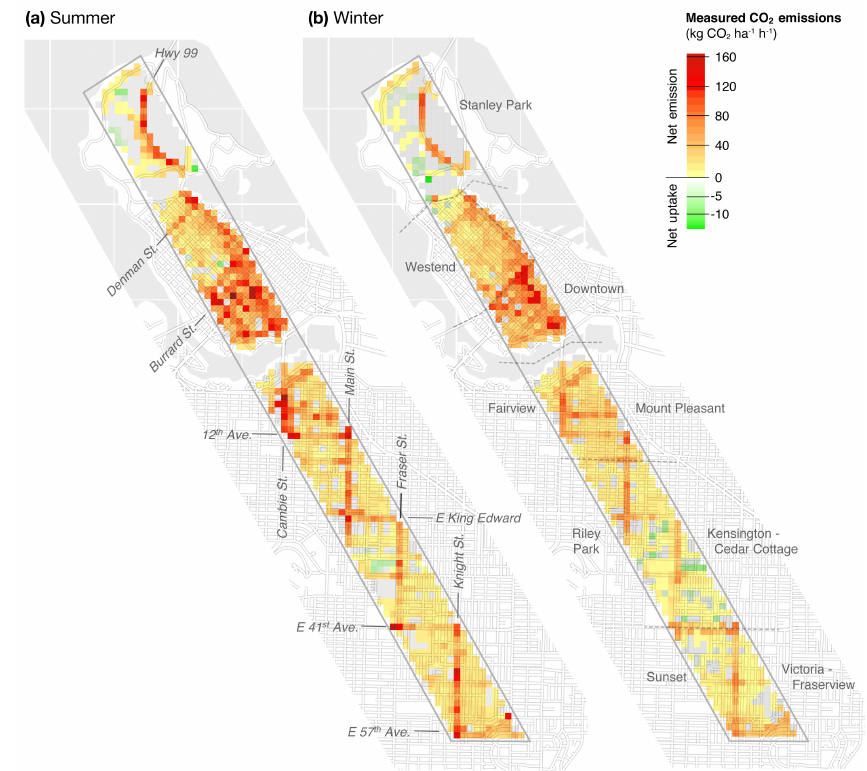
Figure 6. Measured emissions (calculated from mixing ratios using the aerodynamic resistance approach in Eq. 1) for (a) summer and (b) winter campaign at a resolution of 100 ×